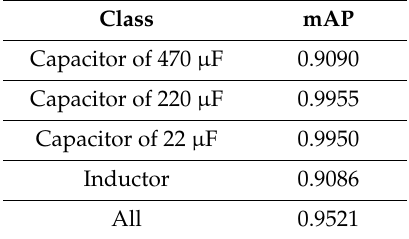
Table 5. Mean average precision (mAP) results of the four electronic